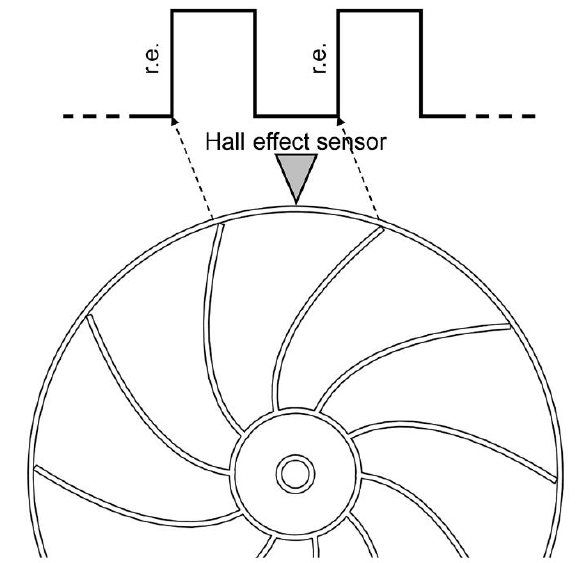
Figure 8. The original instantaneous TC speed signal related to one engine cycle (light grey) and the post-processed one (black). Instantaneous TC speed signal by the moving average method (88 blades). The post-processed signal is referred to the average of multiple engine cycles with the application of the pass-band filter. Data correspond to 1000 rpm at full load. 4. Results 4.1. Experimental Assessment of the Monitoring Methodologies This section is focused on the calibration and assessment of the developed methodologies carried out with the new set of injectors by imposing several injection variations in the cylinders at different